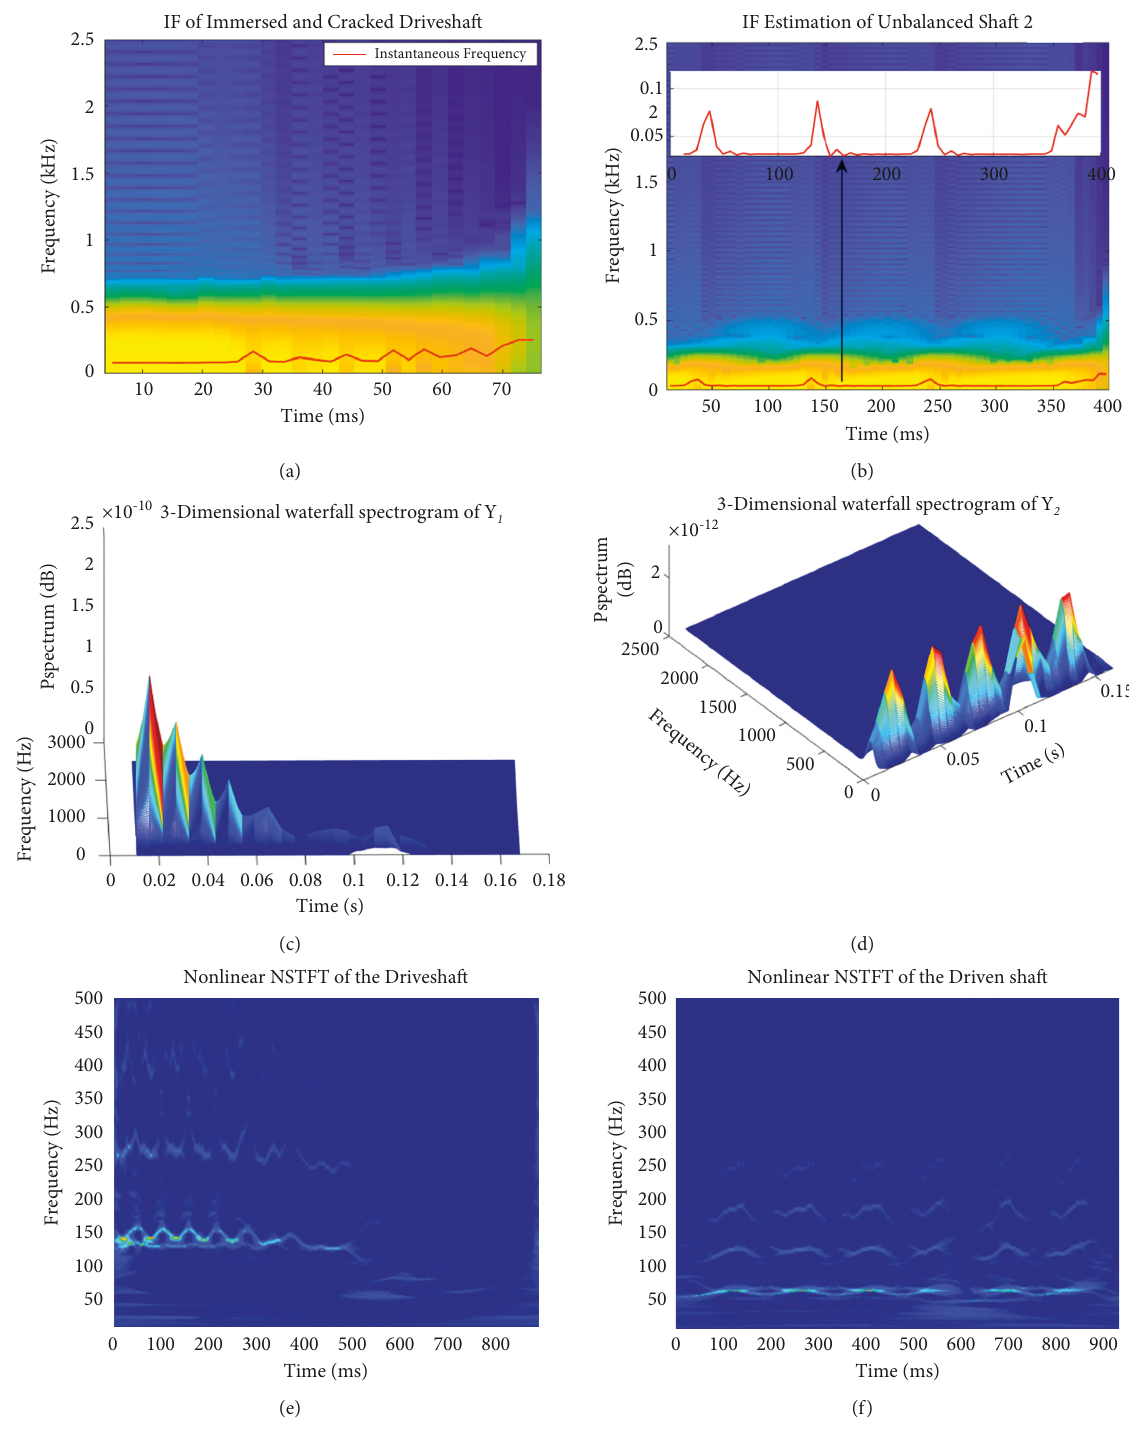
Figure 9: Time-frequency representation of the unbalanced and cracked system in a viscous fluid at 1447.74 rpm. (a) IF estimation of the immersed cracked driveshaft. (b) IF response of the unbalanced driven shaft. (c) The 3D NWSSTrepresentation of the immersed driveshaft. (d) 3D corresponding unbalanced driven shaft. (e) NSTFT from synchrosqueezing wavelet. (f) Corresponding NSTFT of the driven